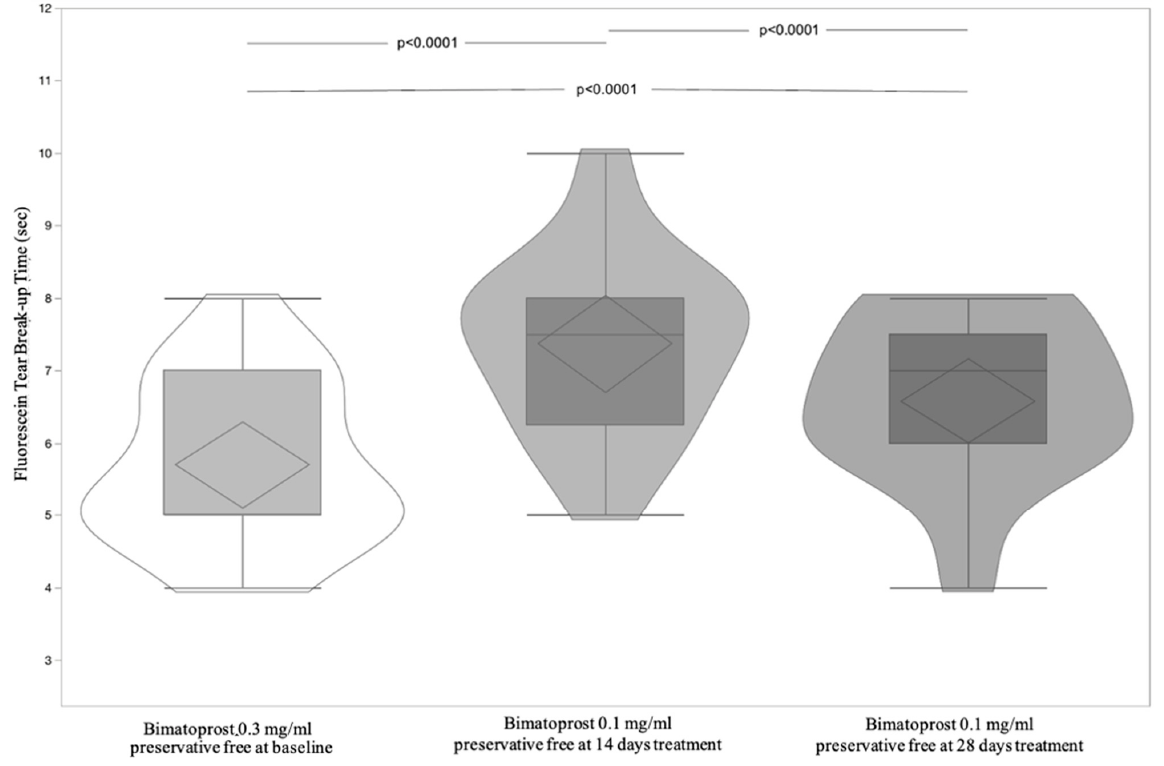
Figure 6. Violin and box-plots of fluorescein tear break-up time by Bimatoprost 0.3 mg/mL preservative-free at baseline and Bimatoprost 0.1 mg/mL preservative-free at 14 and 28 days.